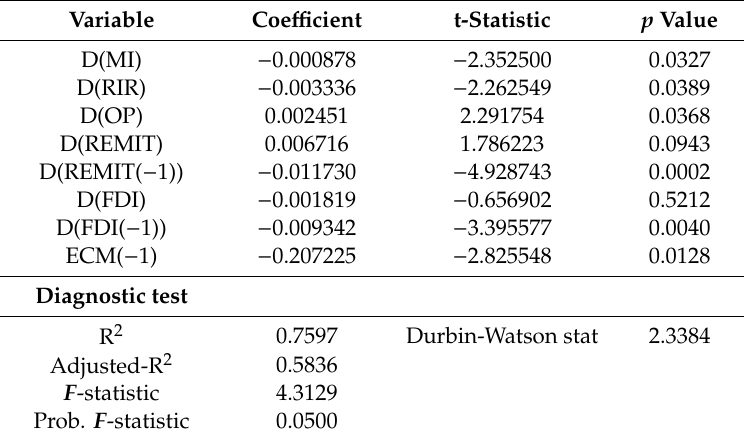
Table 6. Short-run results using autoregressive distributed lag